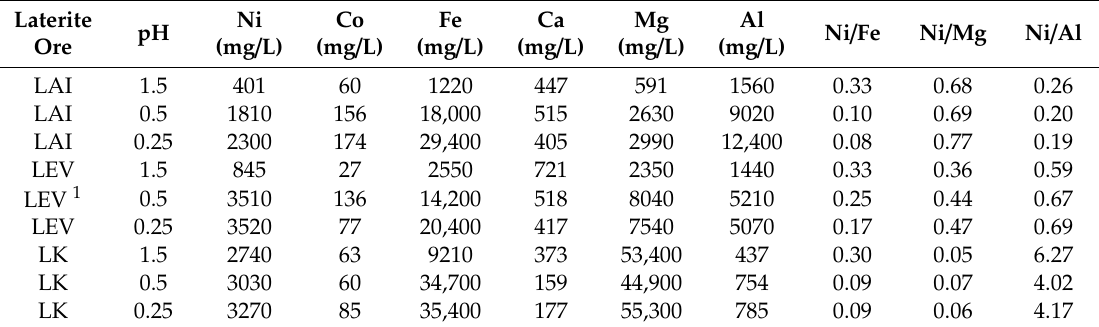
Table 6. Dissolutions of Ni, Co, Fe, Ca, Mg, and Al and e ffi ciency of H 2 SO 4 leaching of the LAI, LEV, and LK laterites under the following conditions: pH 0.25, 0.5, and 0.25, 90 ◦ C, S / L = 30%, 8 h. Selectivity of Ni is compared over Fe, Mg, and Al using the respective ratios and concentrations in the pregnant leach solution